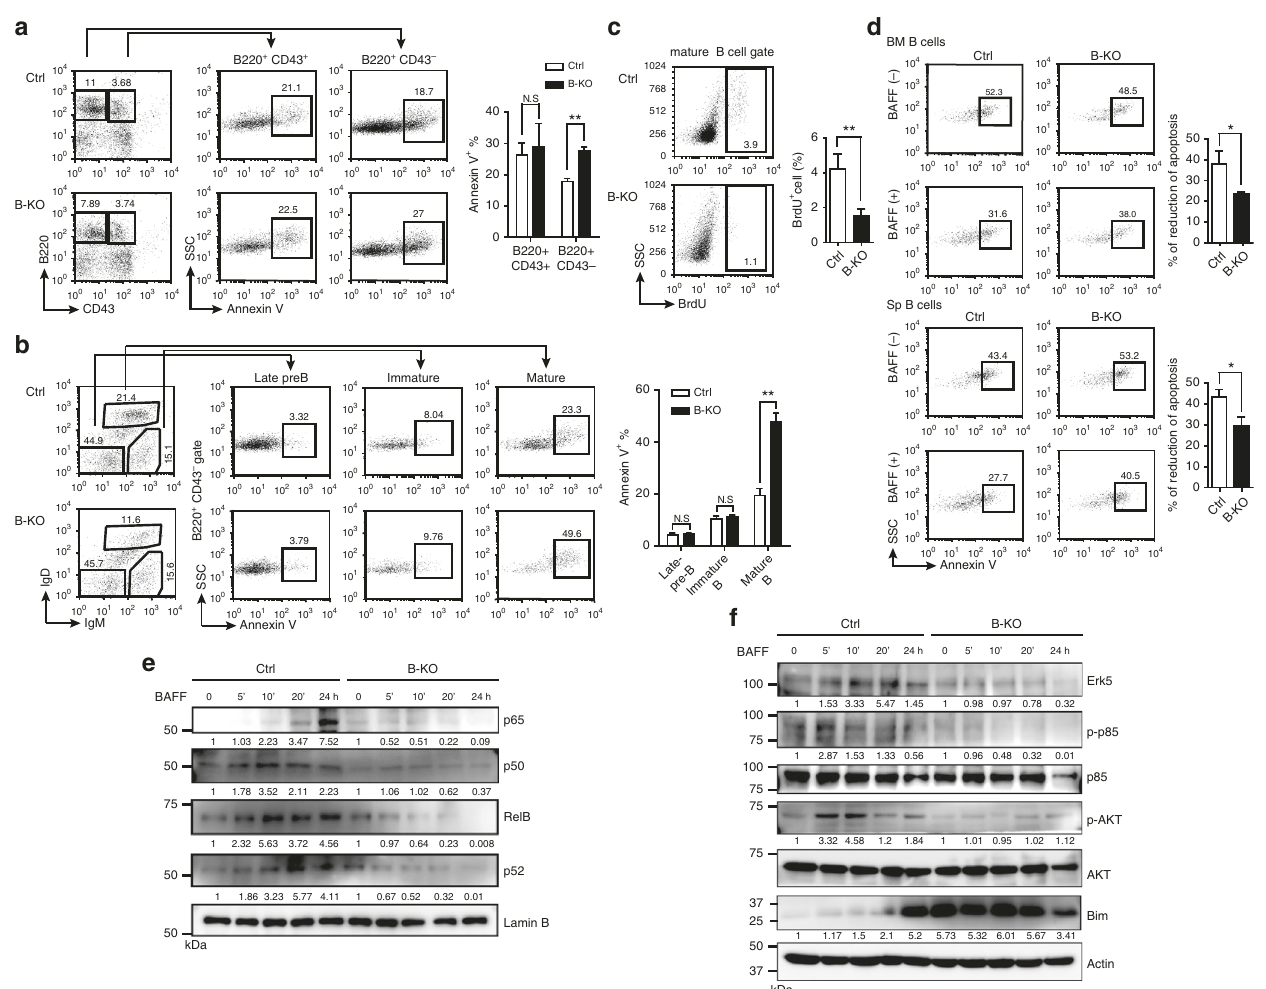
Fig. 2 O -GlcNAcylation in BAFFR signaling regulates the survival of mature B cells. a , b Frequency of Annexin V + cells at various B-cell developmental stages, including pro-B (B220 + CD43 + ) and non-pro-B (B220 + CD43 − ) B cells ( a) , as well as late pre-B, immature and mature B cells within non-pro-B (B220 + CD43 − ) gate ( b) , in bone marrow of Ctrl and B-KO mice. c Frequency of BrdU + mature B cells in Ctrl and B-KO bone marrow. d Frequency of Annexin V + B220 + bone marrow and splenic B cells cultured for 72 h with (+) or without ( − ) recombinant BAFF (rBAFF, 200 ng ml − 1 ). Percentage of reduction of apoptosis in B220 + bone marrow and splenic B cells after BAFF treatment was calculated by (% of apoptosis in untreated group − % of apoptosis in rBAFF-treated group) / (% of apoptosis in untreated group). e Immunoblot of nuclear extracts isolated from rBAFF-treated Ctrl and B-KO splenic B cells at various time points with indicated antibodies against NF- κ B subunits. Lamin B: nuclear protein loading control. f Immunoblot showing the activation of Erk5, p85/PI3K and Akt as well as Bim expression after rBAFF treatment in Ctrl and B-KO splenic B cells at various time points. Actin: protein loading control. The representative data from one of at least three independent experiments are shown. Quanti fi cation of results is shown in the right panel in a – d . The data are the mean ± s.e.m. ( n = 3, a – d ). * P < 0.05, ** P < 0.01 (two-tailed unpaired t test). In e and f , the quanti fi cation of band intensity is indicated. N.S., not signi fi